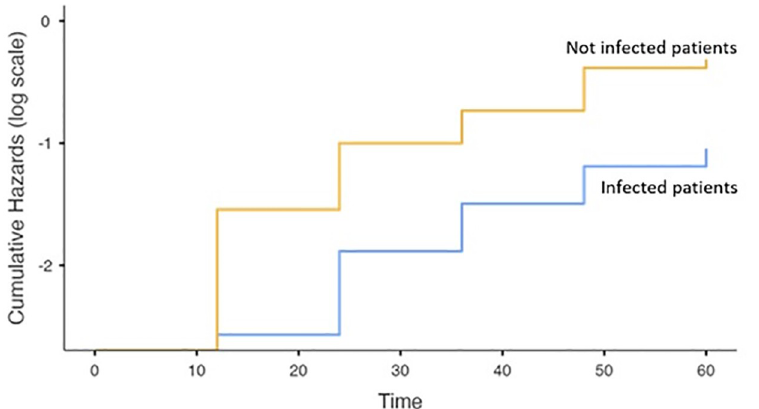
Fig 2. Survival cumulative Hazards between patients with and without infections. Yellow line: not infected patients, blue line: infected patients.